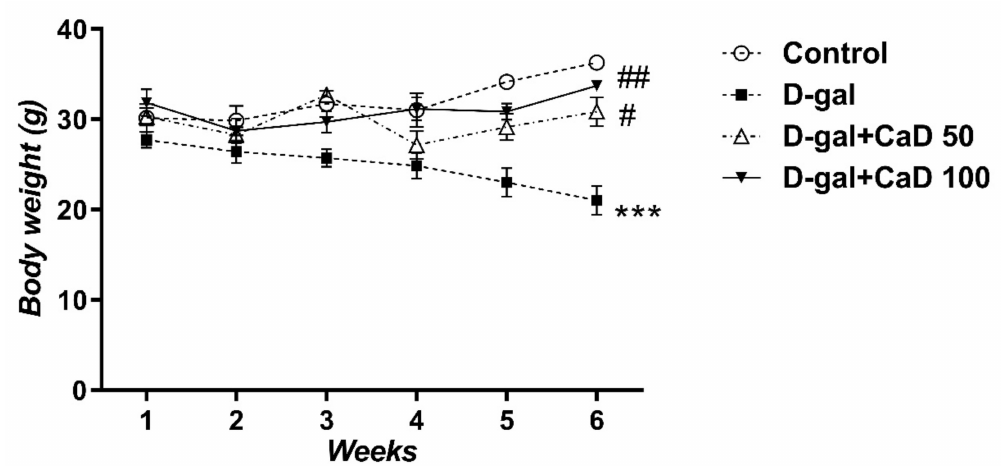
Figure 1. Effect of calcium dobesilate (50 and 100 mg/kg, p.o.) on body weight in D-galactose (D-gal treated) mice. Values are mean ± SEM ( n = 7 in each group). *** p < 0.001 compared to control group; # p < 0.05 and ## p < 0.01 compared to D-gal treated group. Values are mean ± SEM ( n = 7 in each